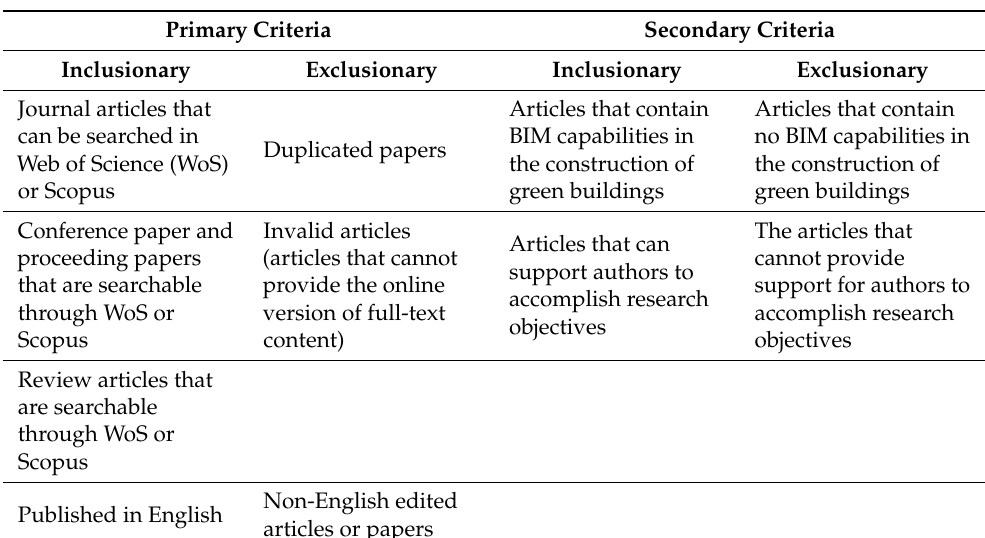
Table 2. Inclusion criteria and exclusion criteria.